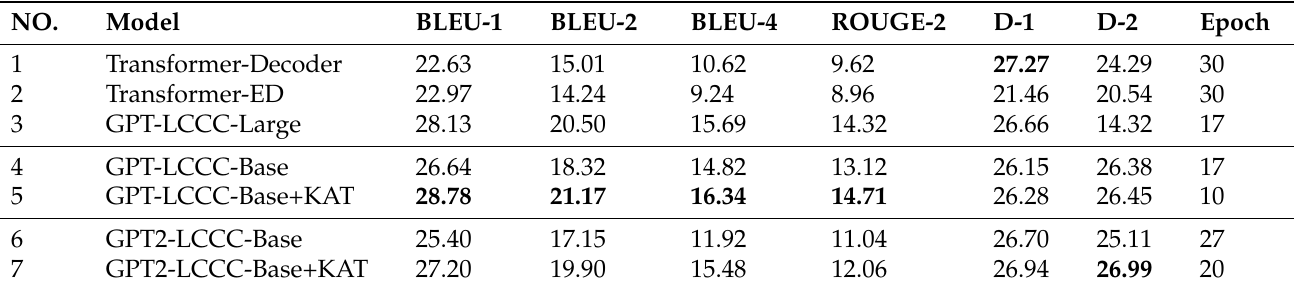
Table 2. Comparison with state-of-the-art results on Chinese Daily-Dialog Dataset. For each evalua- tion metric in every column, the best result is highlighted in